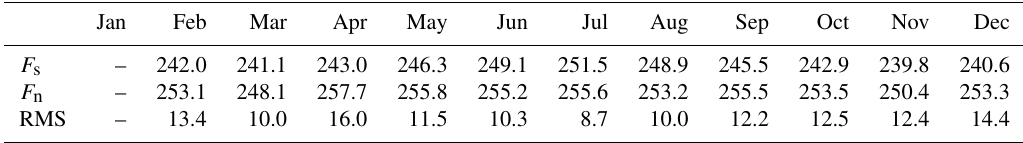
Table 4. LW flux comparisons between NISTAR and CERES SYN1deg for all coincident observations of 2017. F n is the NISTAR flux (Wm − 2 ), F s is the SYN flux (Wm − 2 ), and RMS is the root mean square error between them (Wm − 2 ). Jan